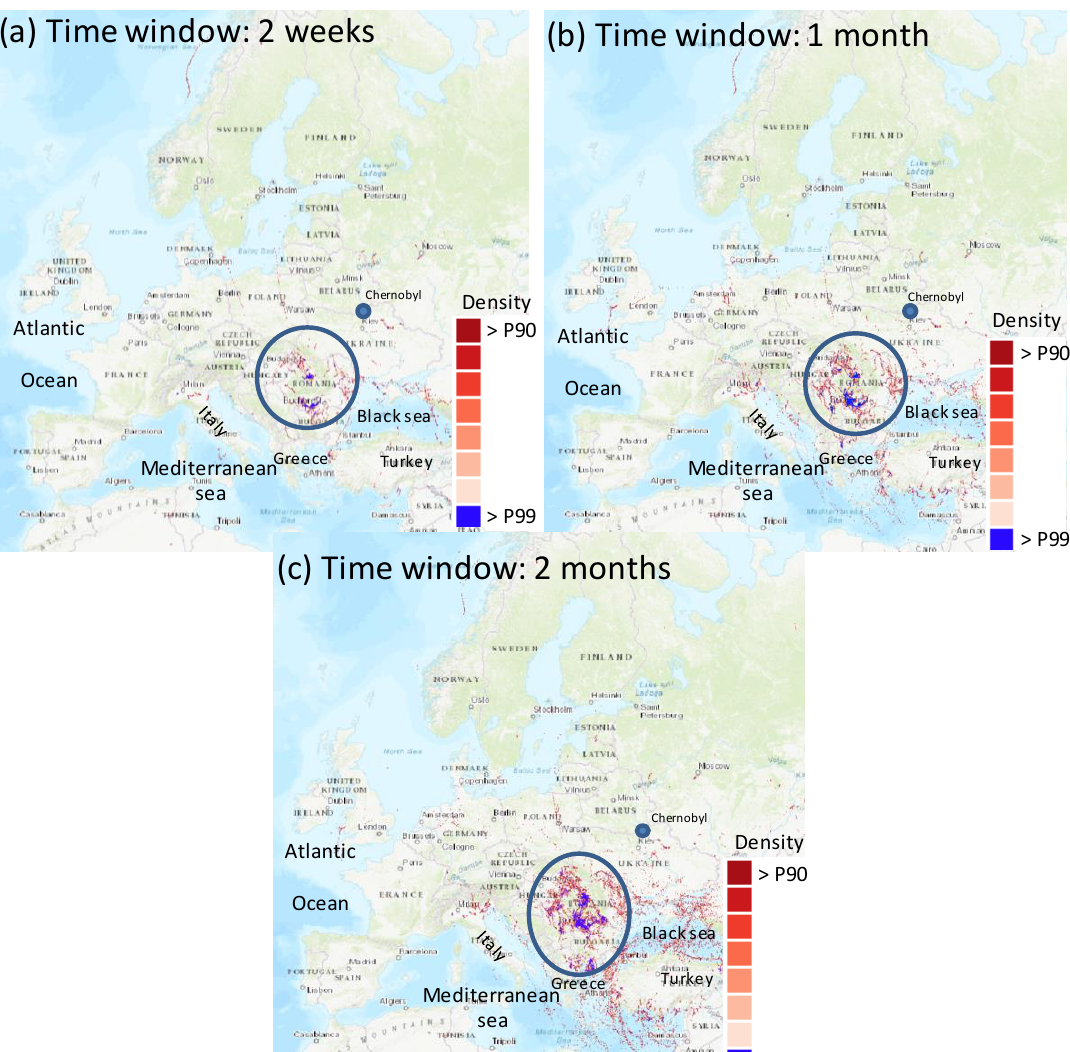
Figure 3. Density plots for 120-h trajectories starting at Chernobyl (blue point) and with a height below 100 m above ground level for ( a ) 2 weeks, ( b ) 1 month and ( c ) 2 months’ time window (reference date of April 25) for the period 2007–2016 (Table 1). The density maps express the density of end-point positions estimated above 90%; quartic kernel function bandwidth 9 km. Blue circles express those areas with a density value above the 99th percentile.